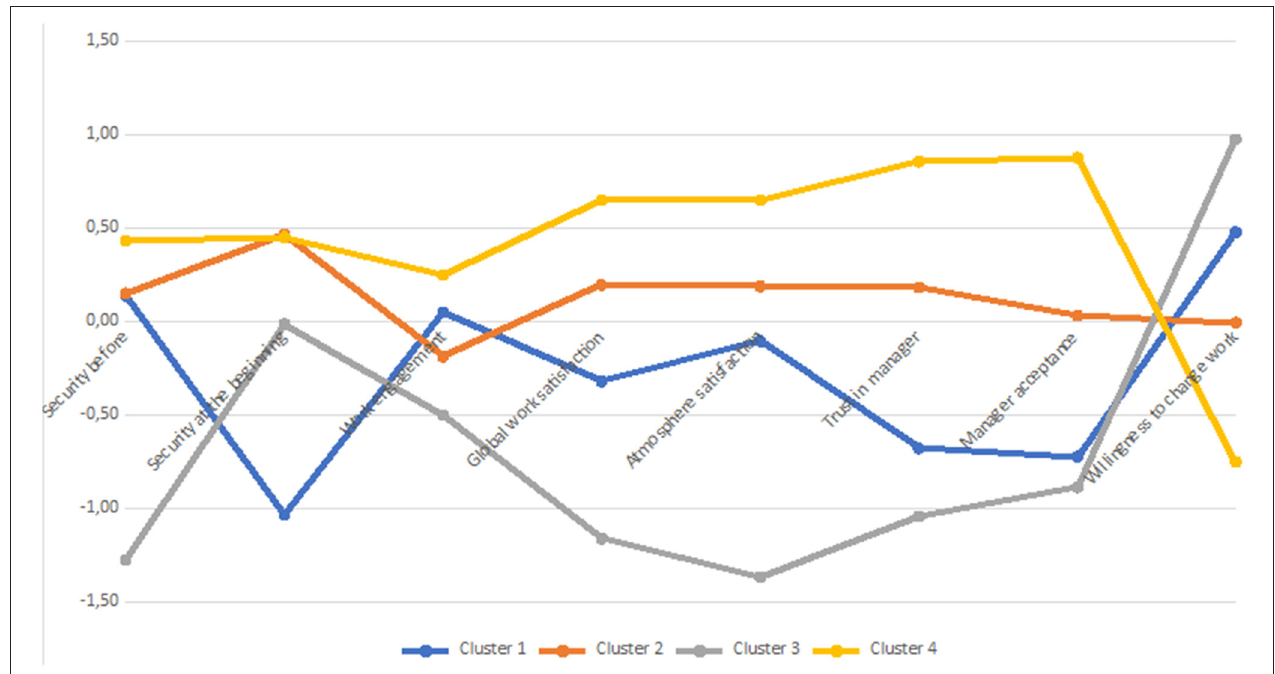
FIGURE 2 | Characteristics of clusters in terms of subjective security and work-related